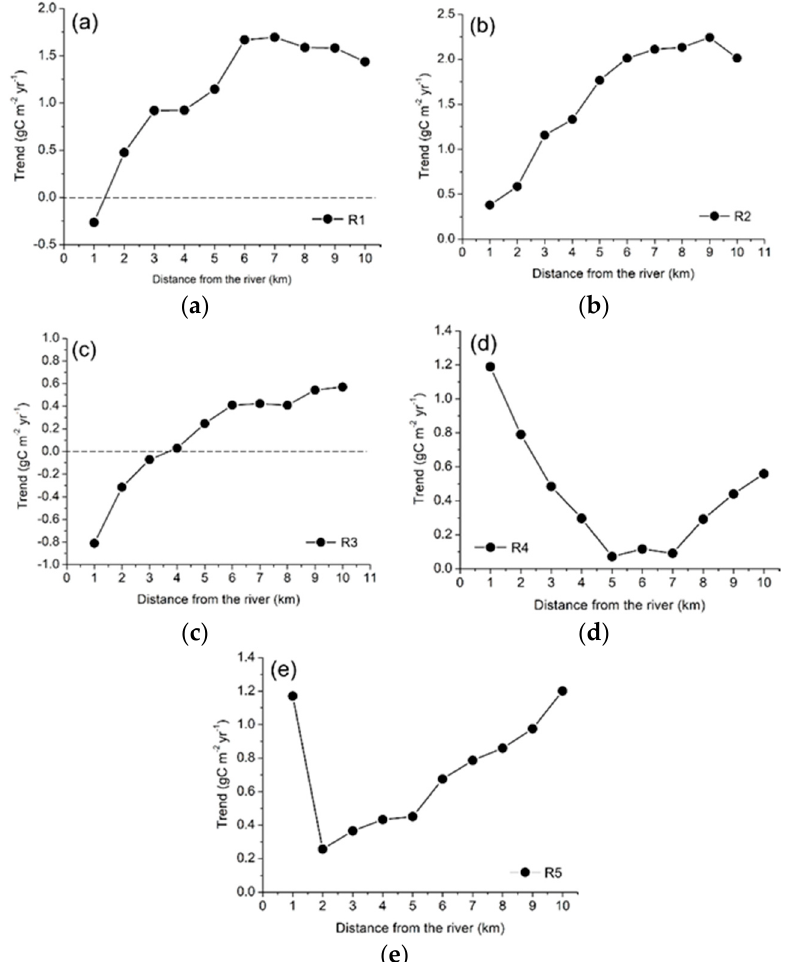
Figure 4. Comparison of the pixel-averaged change trend in NPP within a distance of 1–10 km away from the riverway: ( a ) R1; ( b ) R2; ( c ) R3; ( d ) R4; ( e ) R5.